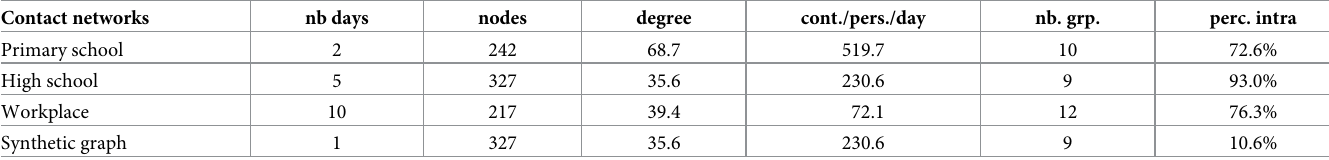
Table 1. Contact graphs characteristics. The three studied Sociopatterns contact networks and the synthetic random graph are detailed in the table. Averaging over the days on which the data was gathered, the high school, in which data was gathered over 5 school days, comprised 327 individuals (students and teachers), each of which was in contact with 35 persons on average (degree), and the student had 230 20-second contacts per day on average (cont./pers./day). The primary school has the highest num- ber of contacts per person in a day, followed by the high school, and finally by the workplace. All graphs have around 10 groups (classes or work departments). The percent- age of intra-group contacts (perc. intra) is at least 70% in real networks while it is around 10% in a random graph with close to ten groups. Contact